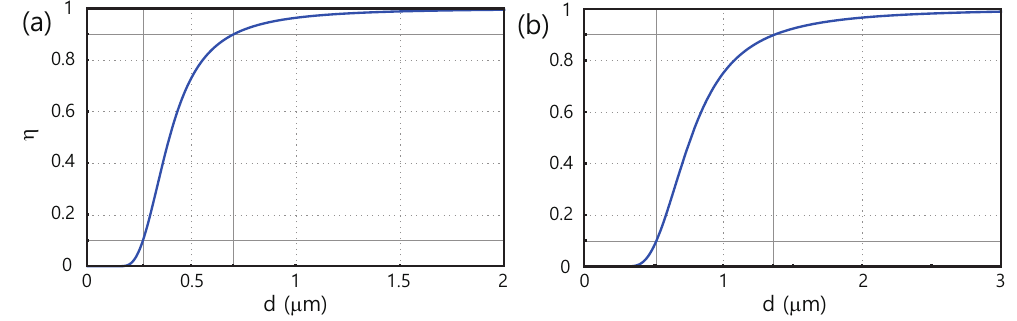
Figure 10. Fraction of power of the fundamental modes inside the core ( a ) at λ = 780 nm and ( b ) at λ = 1.5 µ m. Grey solid lines present the diameters for confining 10% and 90% energy inside the core.